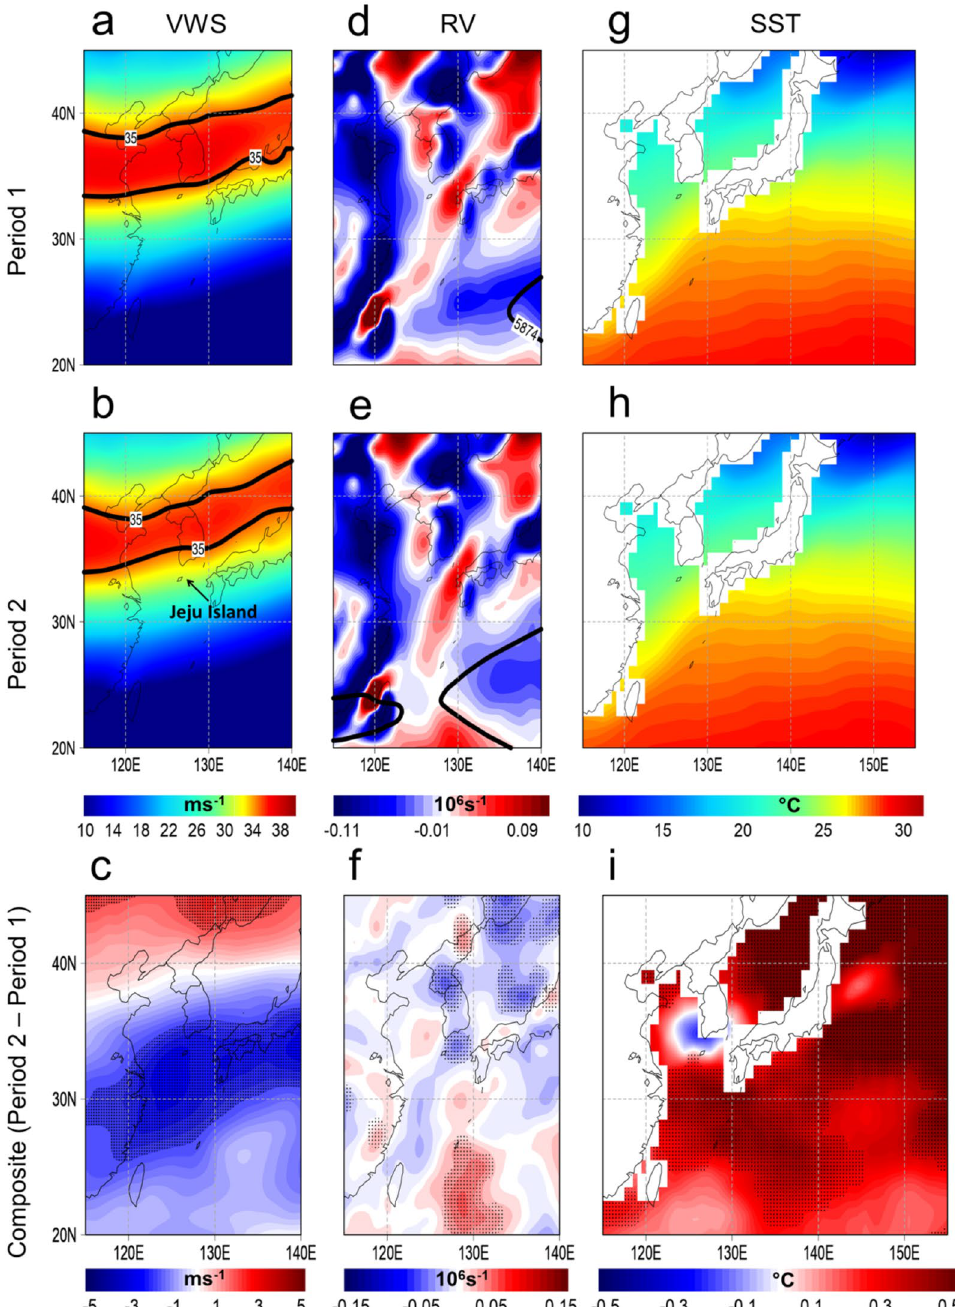
Figure 4. Changes in the large-scale environment. ( a ), ( d ), ( g ) Composite map of vertical wind shear (VWS), relative vorticity (RV), and sea surface temperature (SST) during the Period 1 (1981–2002) in September– October (SO), respectively. ( b ), ( e ), ( h ) same as ( a ), ( d ), ( g ) but for Period 2 (2003–2020) in SO, respectively. ( c ), ( f ), ( i ) Composite difference map in the indicated large-scale environmental parameters between Period 2 and Period 1 in SO, respectively. The dots indicate significance at p < 0.05. In a and b, black lines represent the contour line of VWS (35 ms -1 ) during Period 1 and Period 2, respectively. In d and f, black lines represent the location of the WNP subtropical high (= 5874 gpm) during Period 1 and Period 2, respectively. The maps are plotted using GrADS v2.2.1 (http:// openg rads.